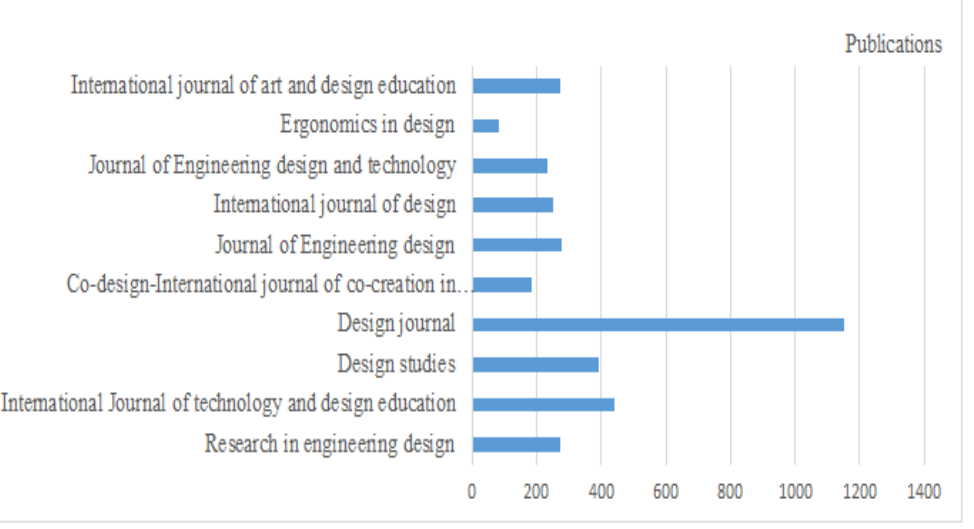
Figure 6. Research articles distribution according to three time spans. 4.2. Clustering Results We changed the time span and uniformed all the keywords by setting lowercase let- ters to produce the expected results. Any other insignificant signs that include marks, signs, words, numbers, and full stops were removed from the clusters because they had no values in the analysis. We generated equations to manipulate the compound terms, for example, to have the design process as a single term as seen; this will help research and interpretations. TF-IDF is a weighing schema commonly and widely used during text mining re- search [46]. This research involved the calculation of the TF-IDF vector for each document instead of using a simple term document frequency by keywords. TF is term frequency while IDF is the inverse of document frequency [47]. The frequency of a particular word in a document is counted using the term frequency. The IDF ’ s value determines a word ’ s importance in a document. Additionally, inverse document frequency is determined by taking the quotient of the number of documents containing the term (DF) and the total number of documents (N) and finding its logarithm (log(N/DF)). The IDF value represents the frequency at which a word appears in a document file. This value may increase when